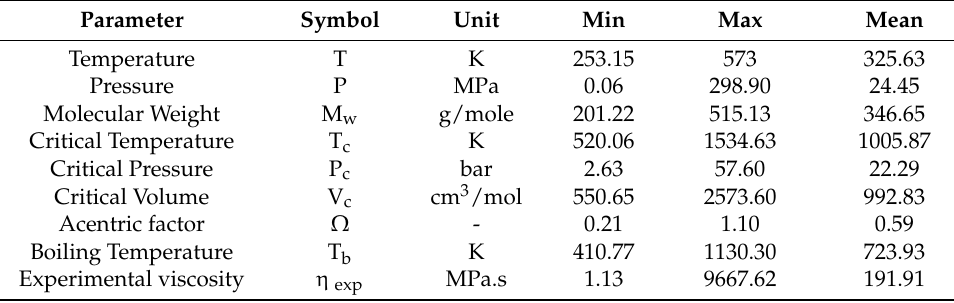
Table 2. Statistical details about gathered databank in the present